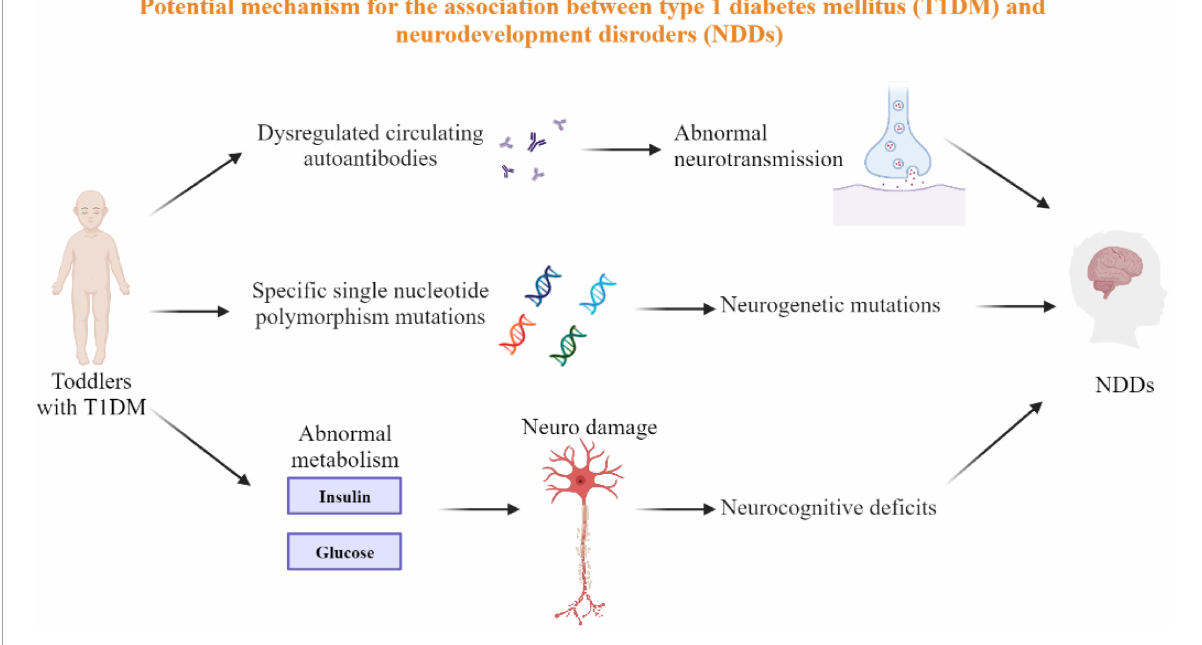
FIGURE2 The potential mechanism of T1DM and NDDs. Three possible potential mechanisms for the interaction between type 1 diabetes and neurodevelopmental disorders are circulating autoantibody dysregulation, specific single nucleotide polymorphism mutations, and abnormal insulin and glucose concentrations, all of which involve substances that are associated with both T1DM and